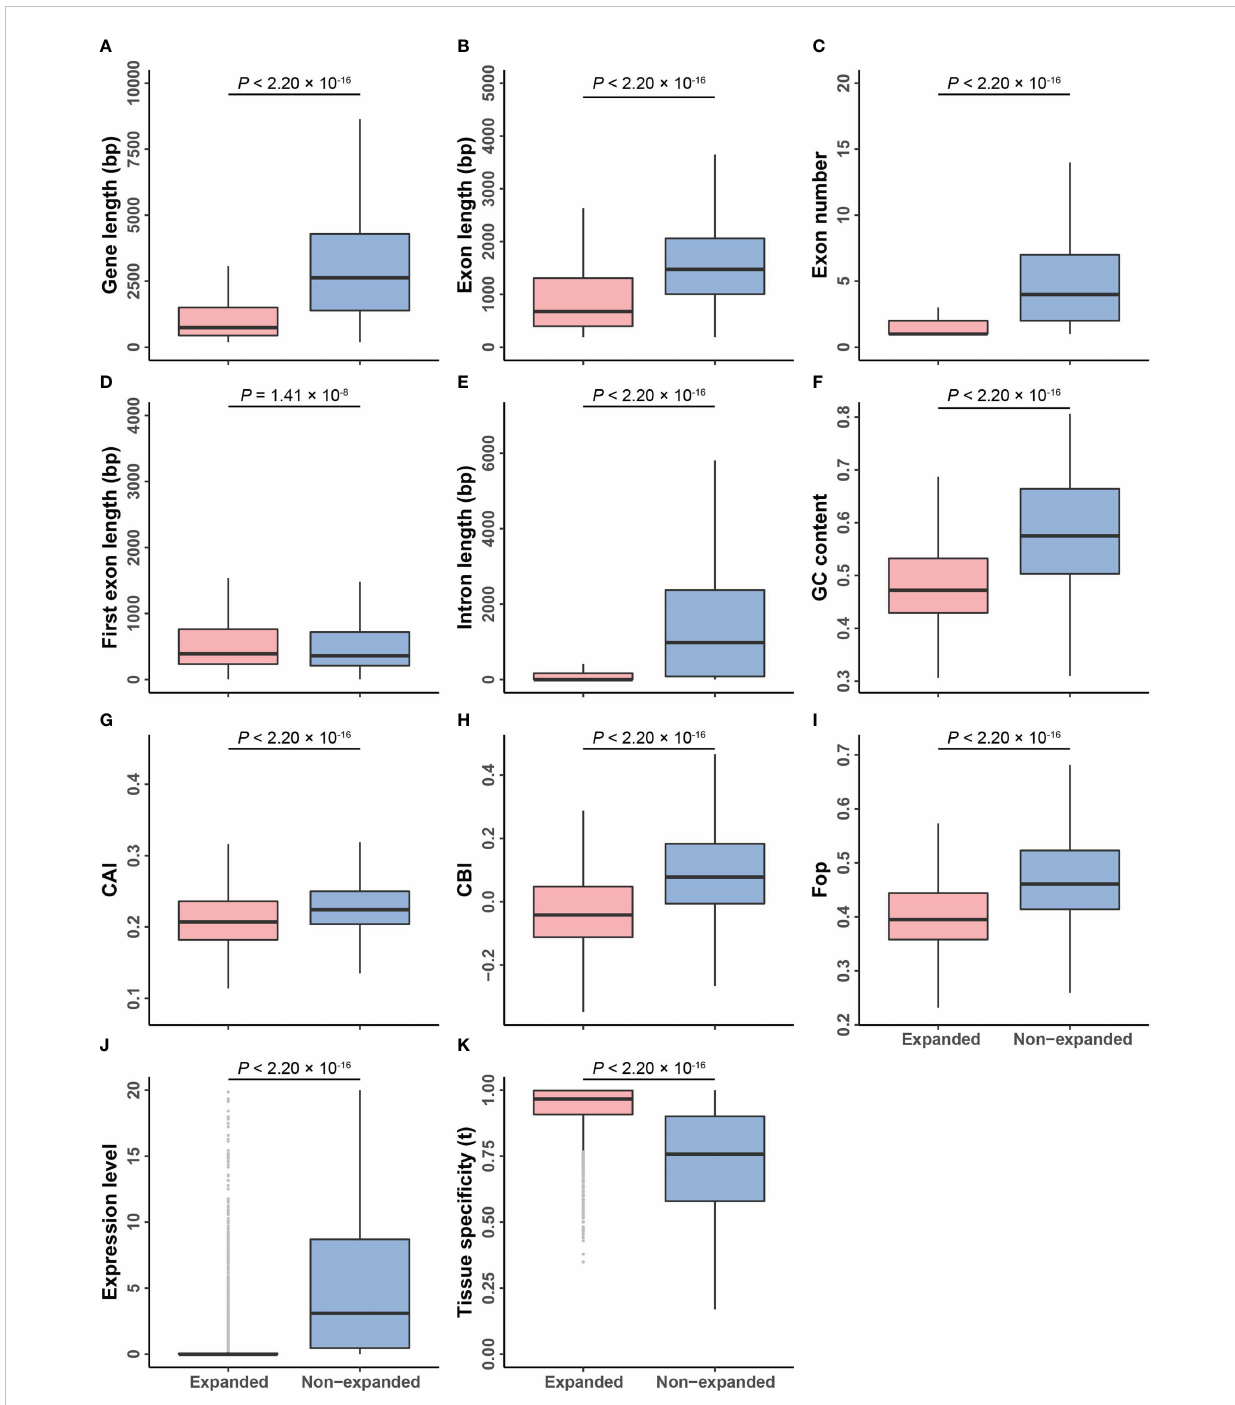
FIGURE 6 Comparisons of genomic features between expanded and non-expanded genes. (A – K) The box plots of gene length, exon length, exon number, fi rst exon length, intron length, GC content, CAI, CBI, Fop, expression level, and tissue speci fi city between expanded and non-expanded genes. The line in the box is the median value, and the lines at the bottom and top of each box are the fi rst (lower) and third (higher)